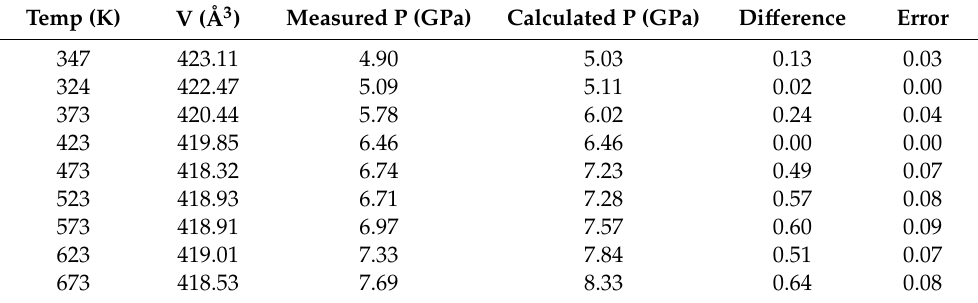
Table 8. List of heated DAC experiments comparing measured pressure using the Cu standard versus calculated pressures using the Fei thermal EOS [40] parameters. Di ff erence is calculated by subtracting the measured pressure from the calculated pressure. Error is calculated by dividing the di ff erence by the measured pressure. Temp